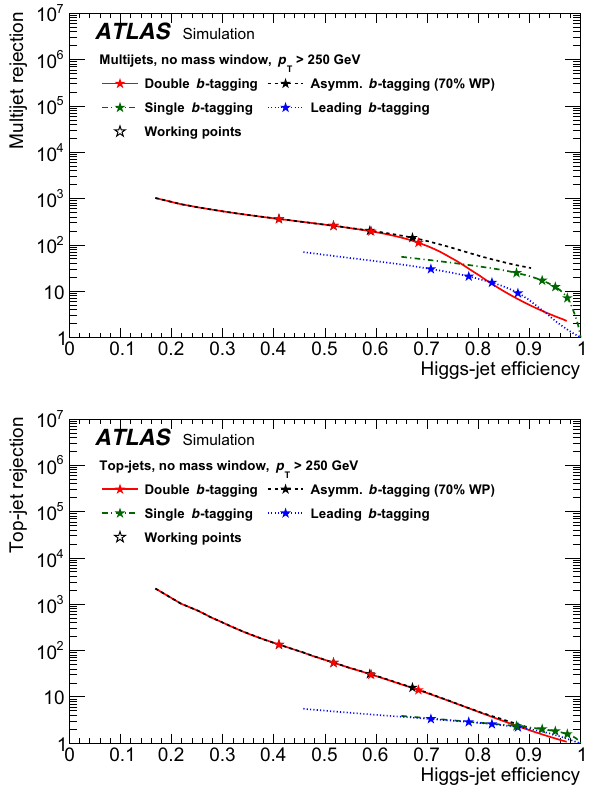
Fig. 3 The multijet (top) and the top-jet (bottom) rejection as a func- tion of the Higgs tagging efficiency for large- R jet p T above 250 GeV (left) and above 1000 GeV (right) for various b -tagging benchmarks defined in Sect. 6.2. The stars correspond to the 60%, 70%, 77% and